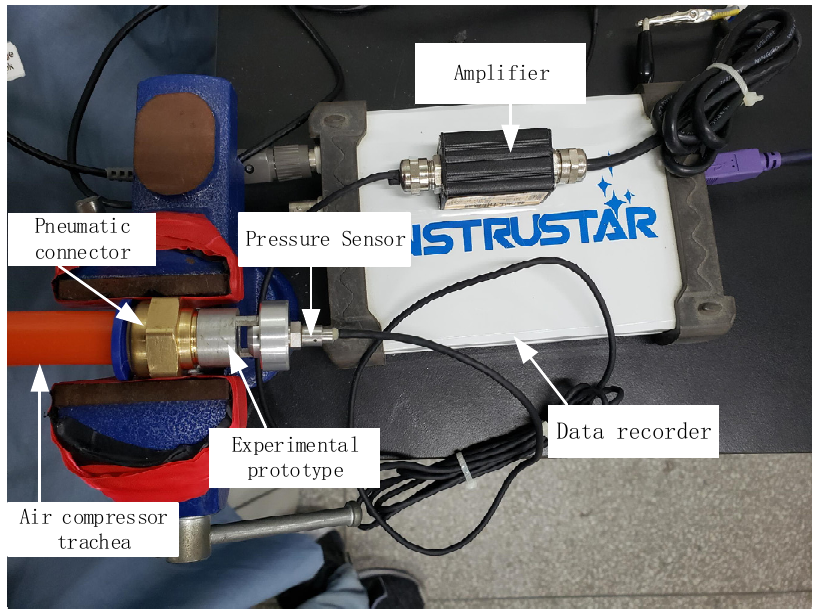
Figure 5. Test instrument.